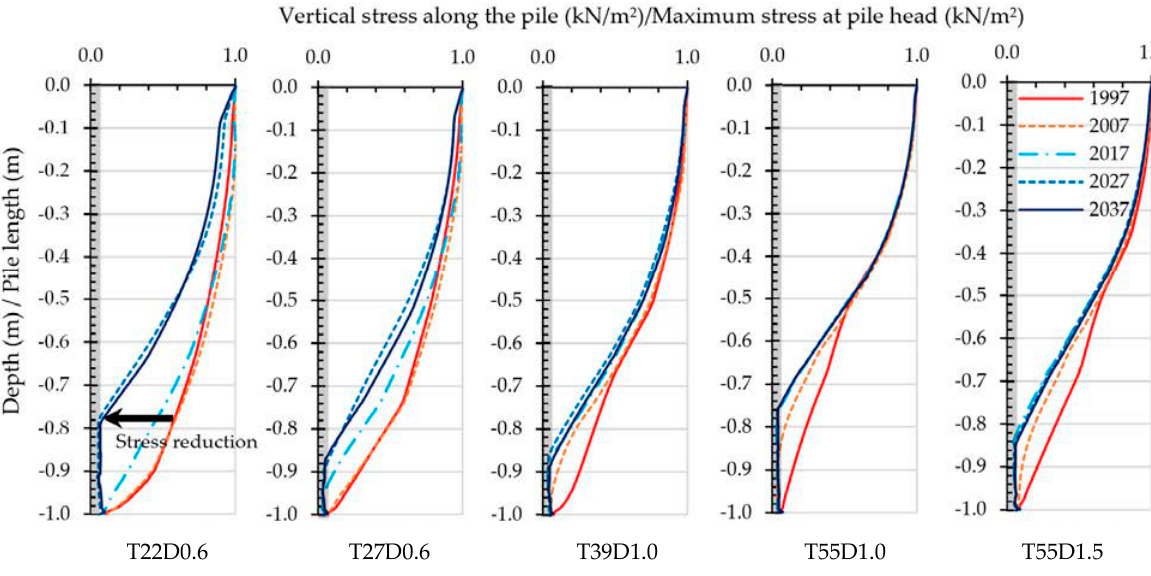
Figure 11. Stress distribution along the pile.